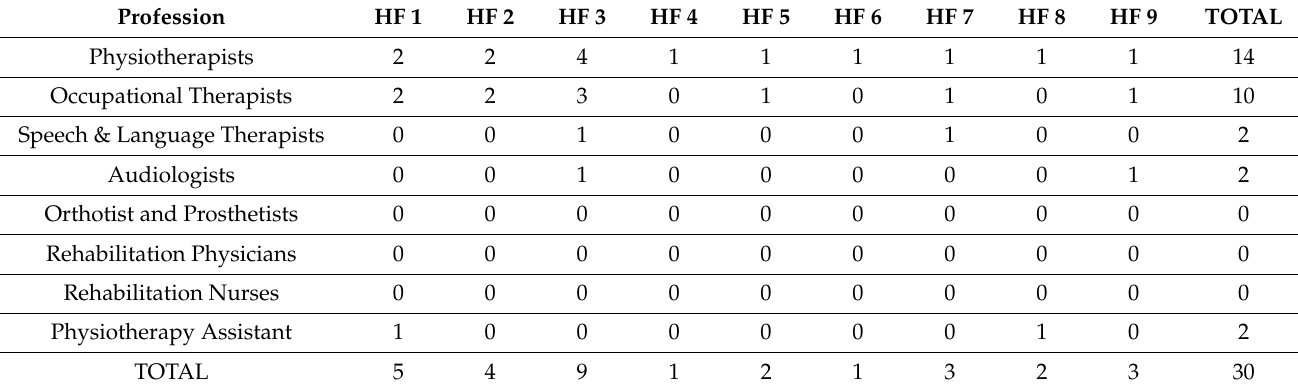
Table 3. Number of rehabilitation providers by profession (full-time posts) in OR Tambo district hospitals .